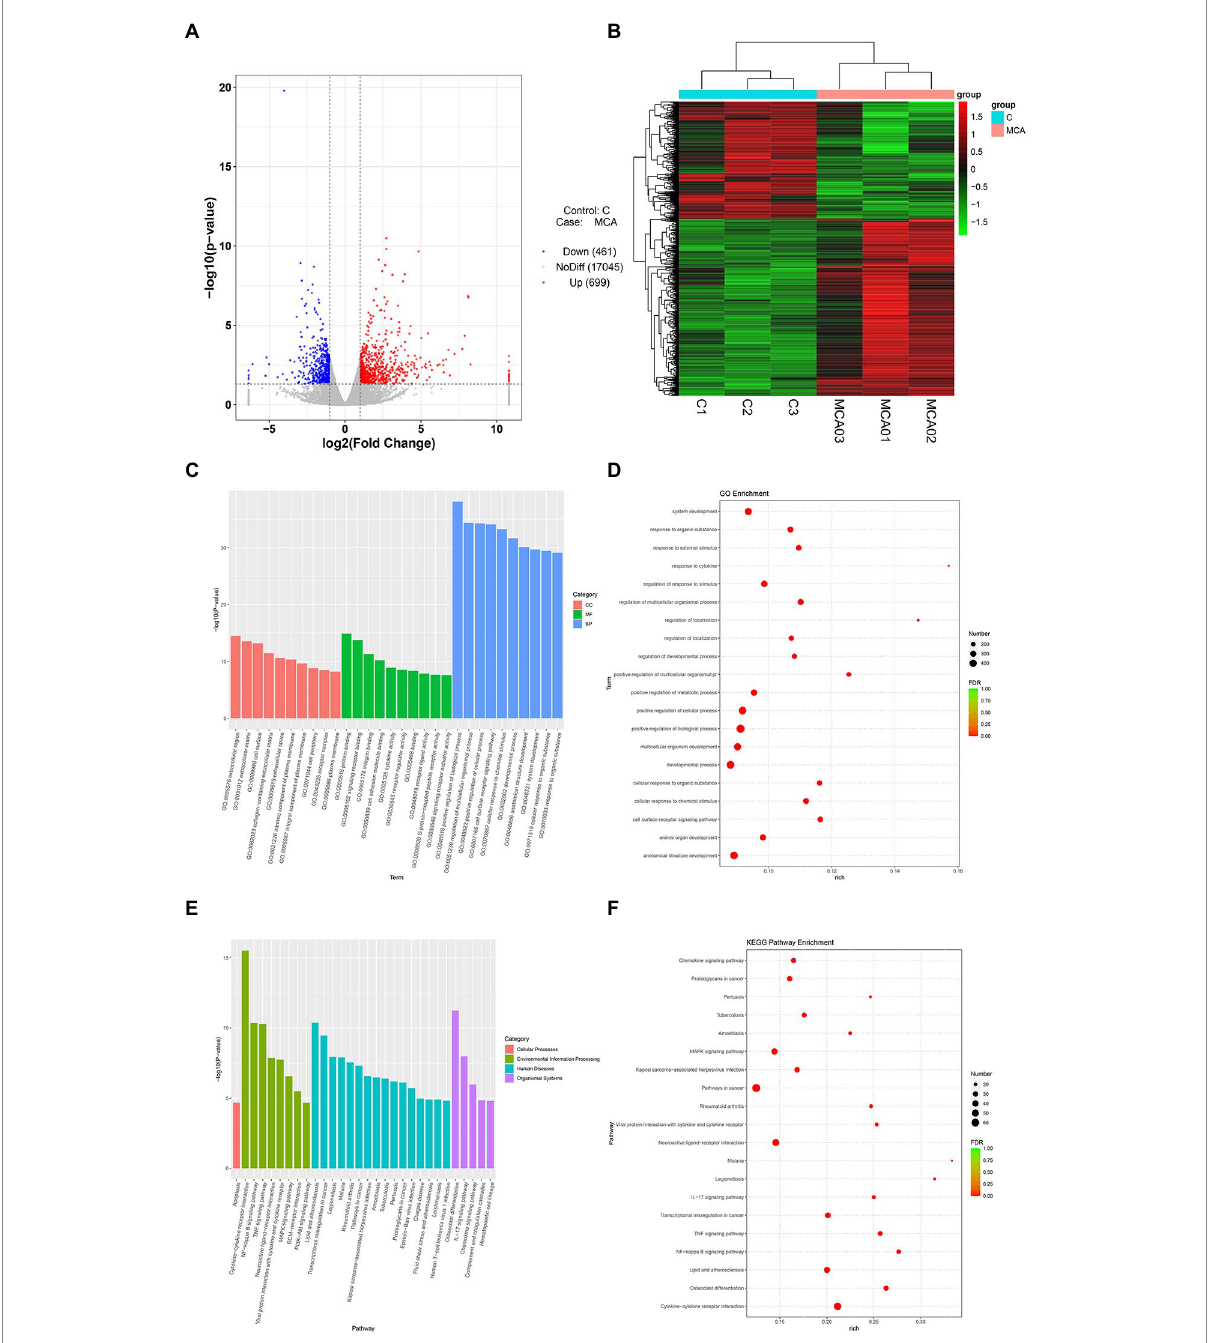
FIGURE 2 Transcriptional analysis of DEGs in brain tissues from IS rats ( N = 6 each group). (A,B) Volcano plot and heatmap of DEGs between the Model (MCA01-MCA03) and the Sham groups (C1-C3). The genes with |log2FoldChange| > 1 and p value <0.05 defined as DEGs. (C,D) GO enrichment analysis of the DEGs. Column chart, top 10 GO terms with minimum p value in each of MF, BP, and CC were shown. MF, molecular function; BP, biological process; CC, cellular component; Bubble chart, top 20 GO terms with minimal FDR value were shown. (E,F) KEGG pathway analysis of the DEGs. Column chart, top 10 KEGG pathways with minimum p value in each category were shown. Bubble chart, top 20 KEGG pathways with minimal FDR value were